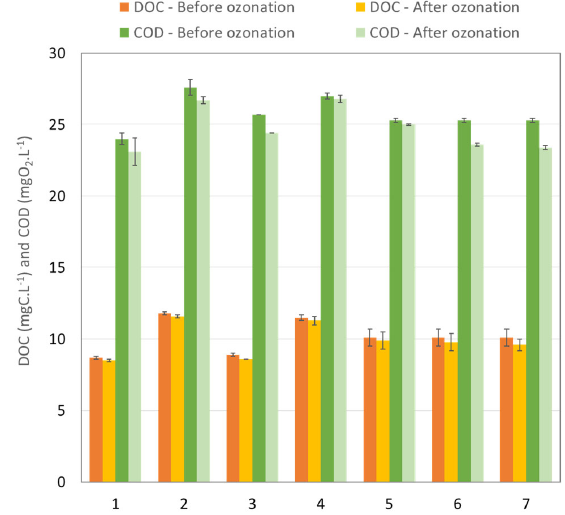
Figure 4. DOC and COD before and after each ozonation experiment. The number in the x -axis corresponds to the number of the experiments in Table 5.